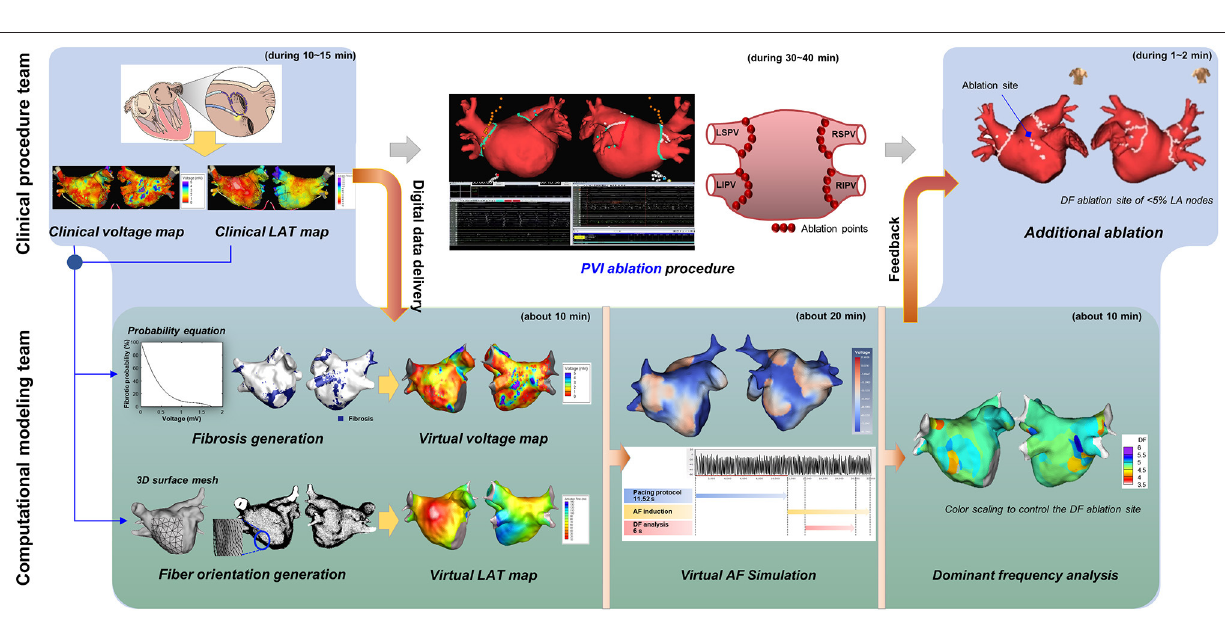
FIGURE 2 | CUVIA-AF 2 approach